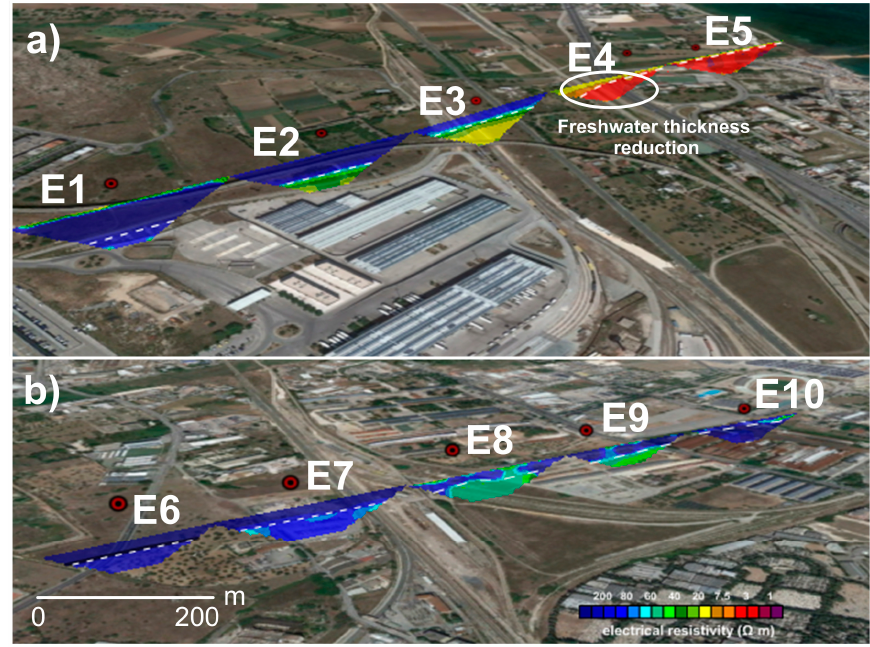
Figure 7. Inverted ERT profiles at Line A ( a ) (from E1 to E5) and at Line B ( b ) (from E6 to E10): ERT model error: <5%. E4 shows freshwater thickness reduction due to seawater intrusion.